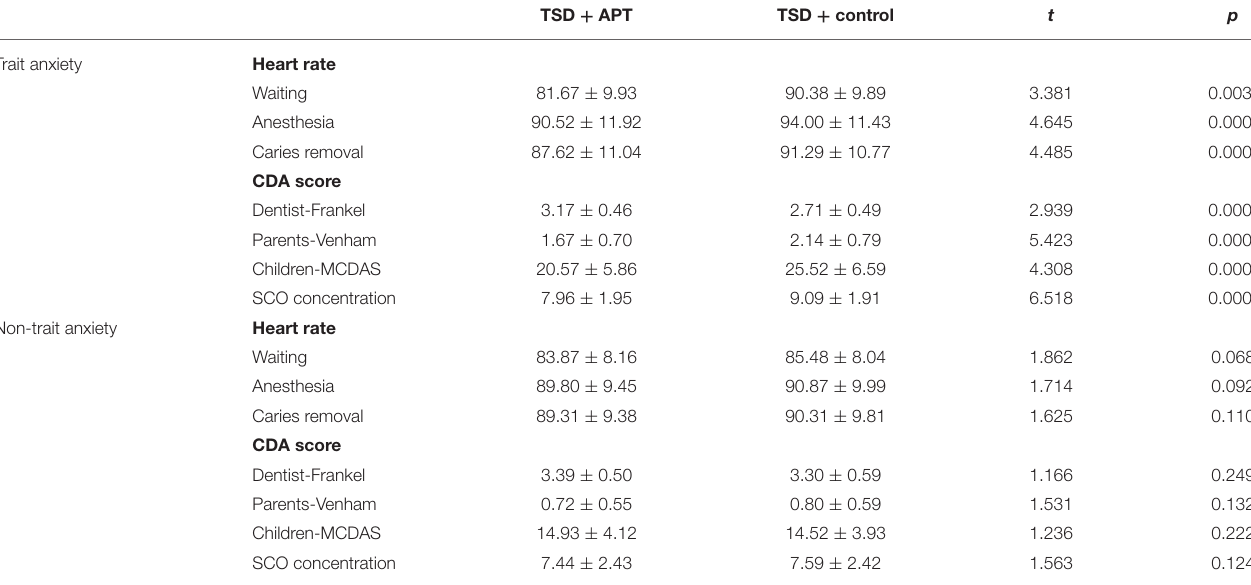
TABLE 2 | Comparison of anxious and non-anxious